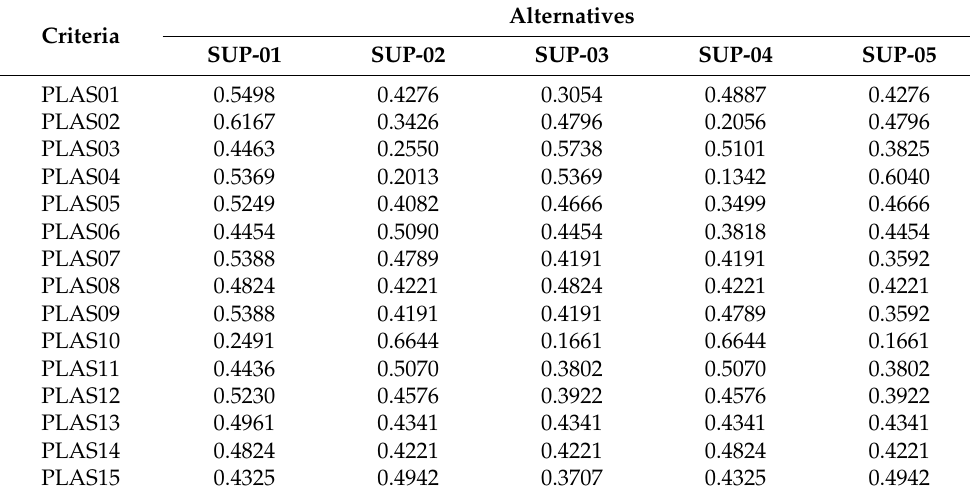
Table 3. Normalized matrix.